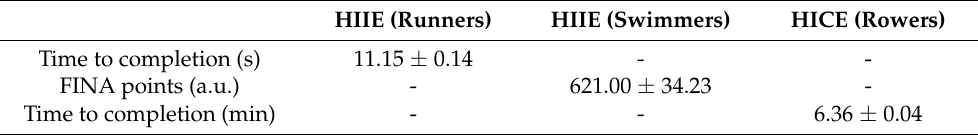
Table 2. Exercise performance of